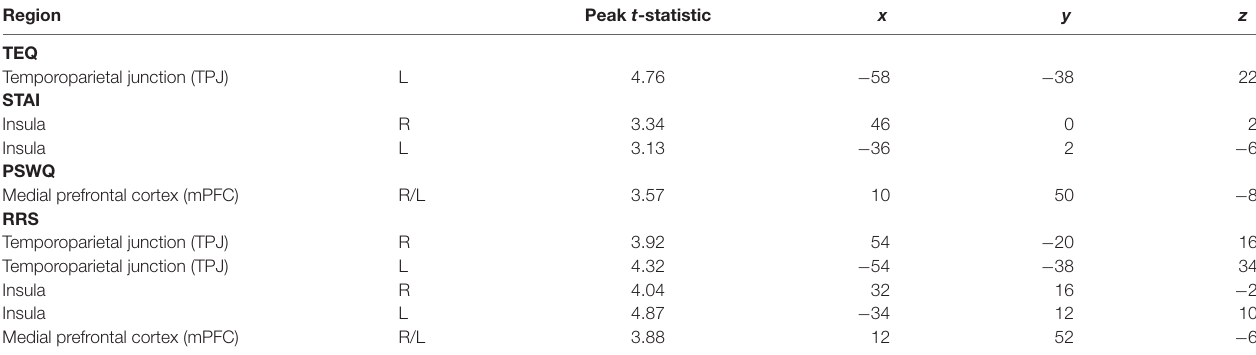
TABLE 4 | Neuroimaging results for questionnaire score regressions, as shown in Figure 4 . Region